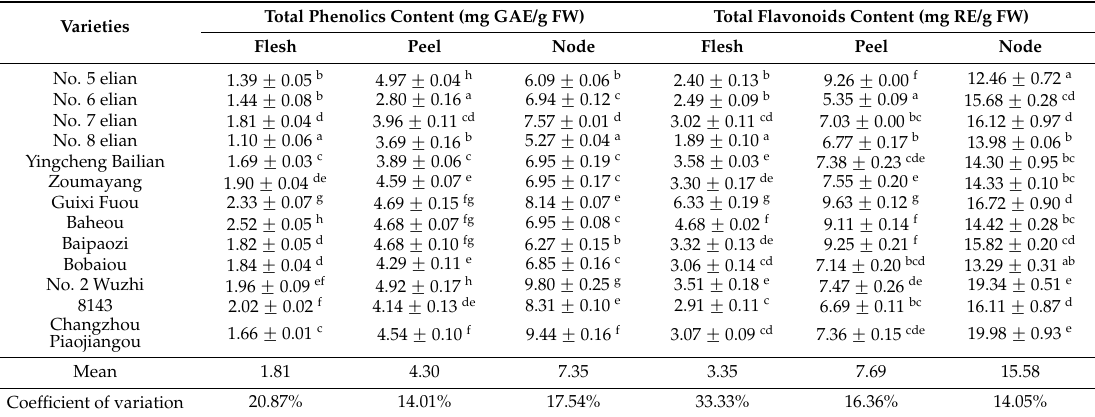
Table 1. Contents of total phenolics and total flavonoids in the different parts of lotus root varieties.